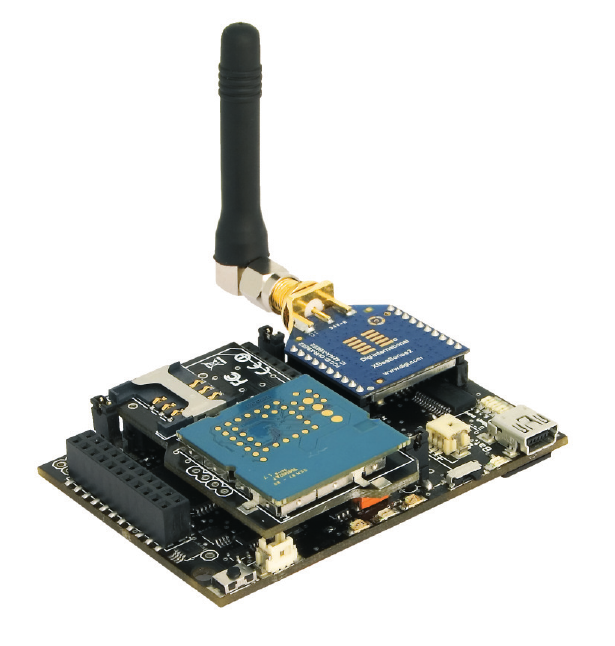
Figure 5. A Waspmote Device (courtesy of Libelium).